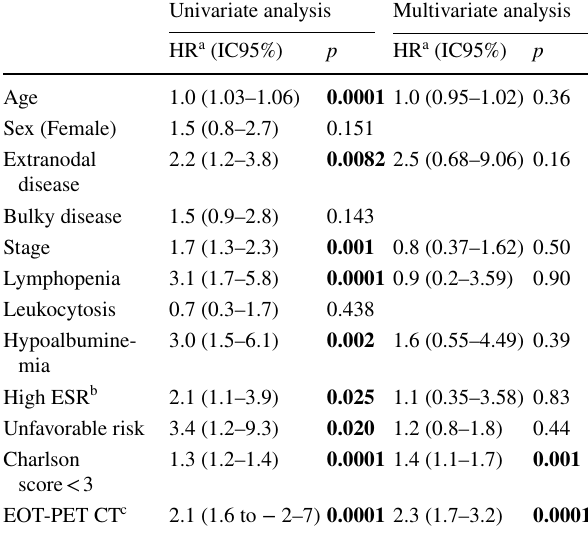
Table 4 Univariate and Multivariate